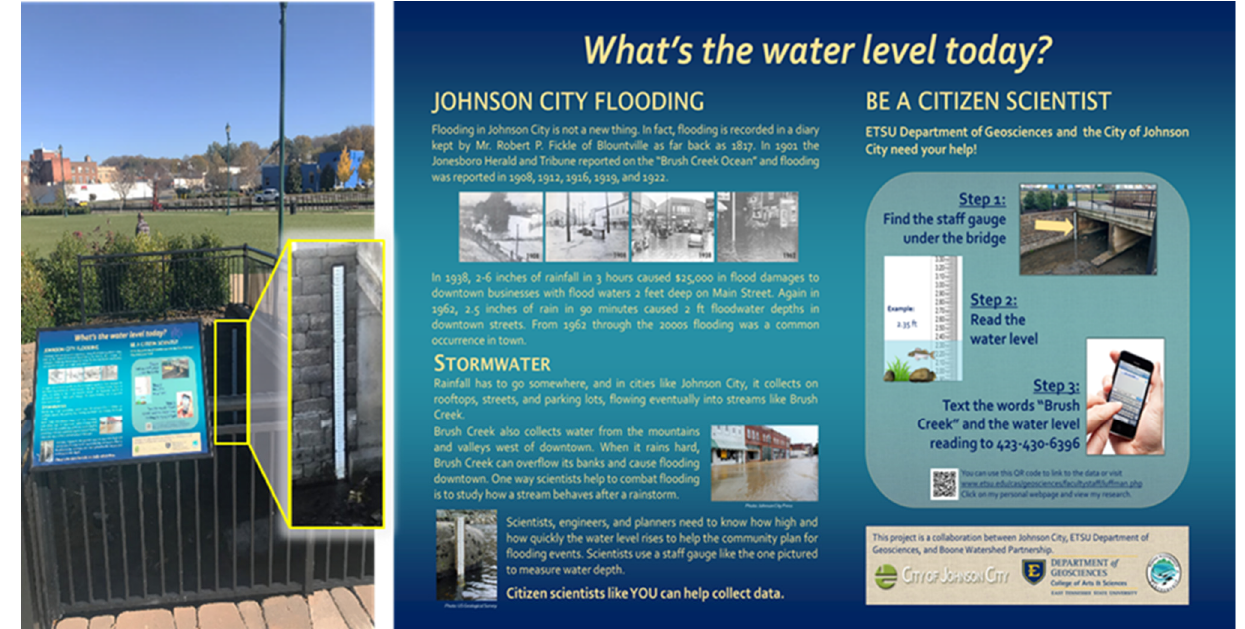
Figure 2. Educational sign provides instructions for data collection and contribution via text mes- sage.